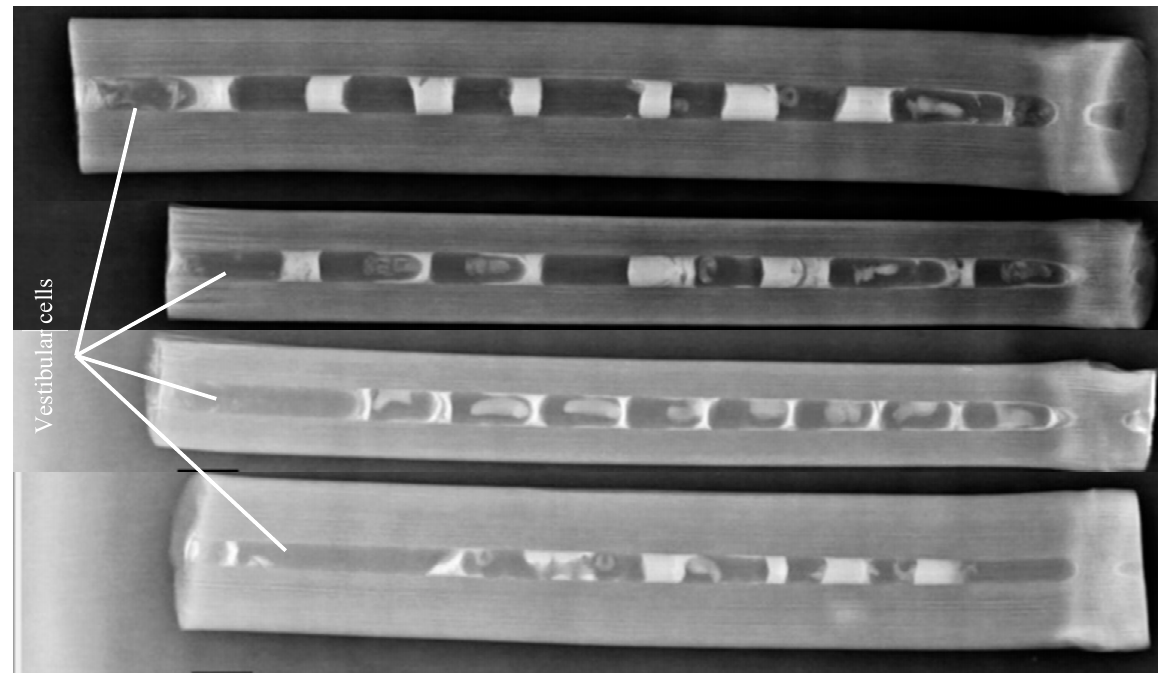
Figure 1. X-ray photographs showing four nests of Megachile cephalotes . Nest entrance is at the left.